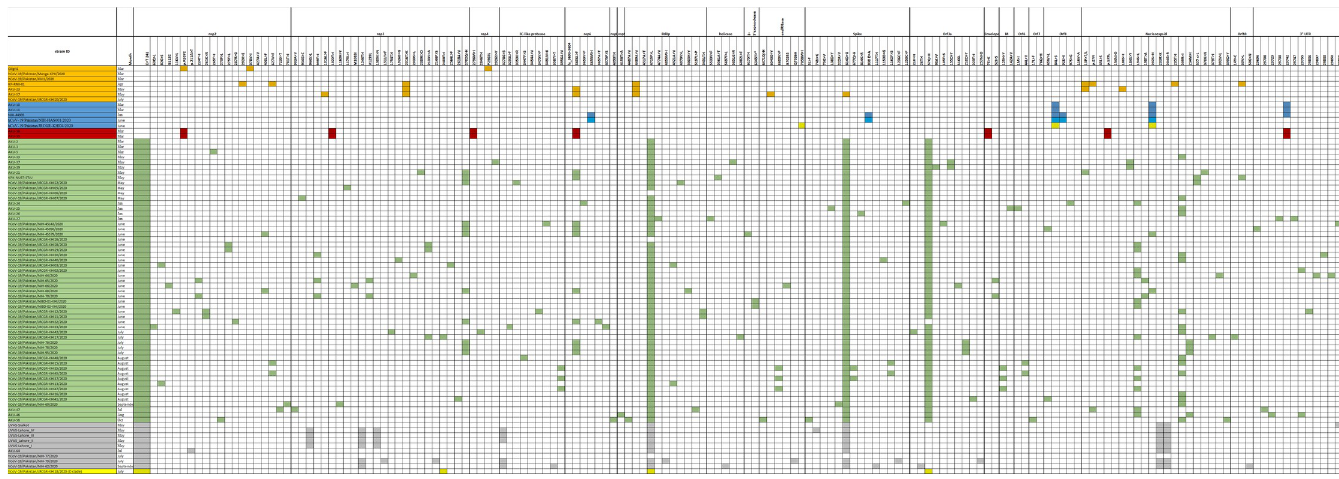
Fig 4. Genetic variants found in SARS-CoV-2 genomes. Clade and time-wise association of genome variants identified in seventy-nine full-length SARS-CoV-2 isolates are identified. Variations of upstream, downstream and non-synonymous SARS-CoV2 genome are presented in the grid format. The isolates represented clades L (n = 7), S (n = 5), V (n = 2), GH (n = 55), GR (n = 9) and O (n = 1). Colors represent clades as, L (orange yellow) S (blue), V (red), G (dark green), GH (light green), GR (grey) and O (yellow).